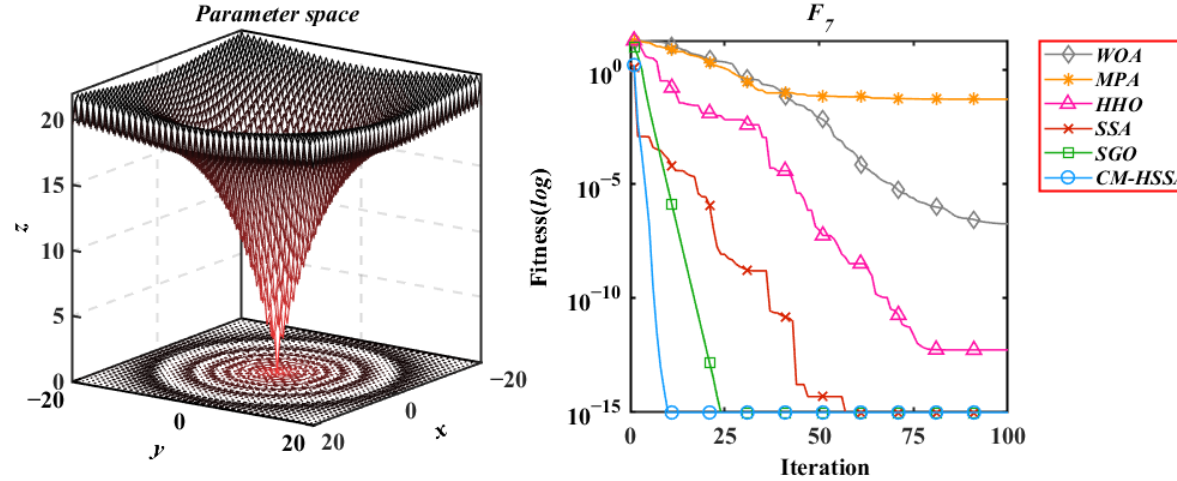
Figure 16. Ackley’s Function.